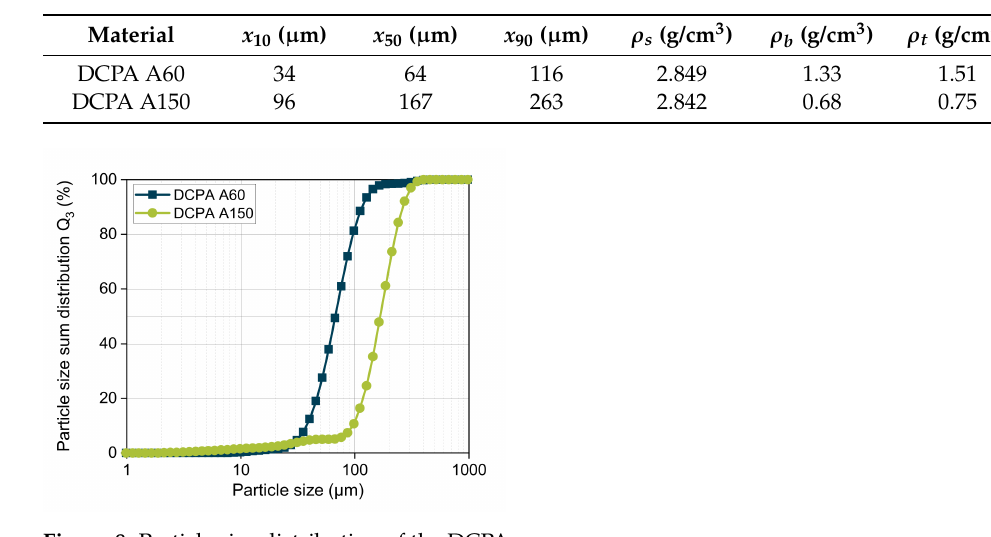
Table 3. Characteristic particle sizes, solid, bulk, and tapped density for DCPA A60 and A150.